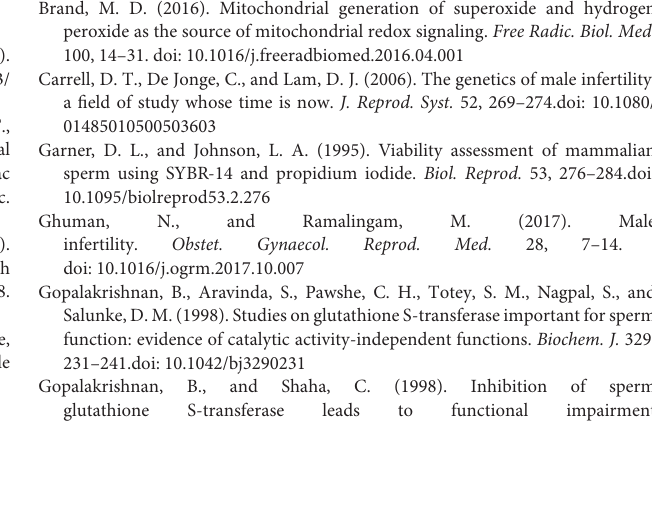
Supplementary File 1 | Supplementary information for Materials and